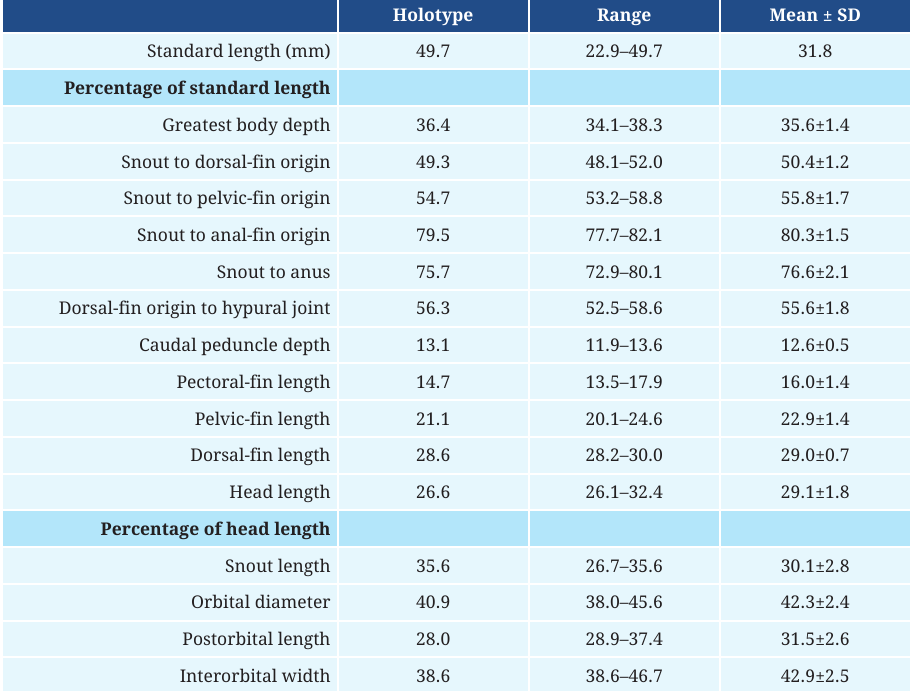
TABLE 1 | Morphometric data for Cyphocharax cramptoni N = 11 (number of specimens measured). SD = standard